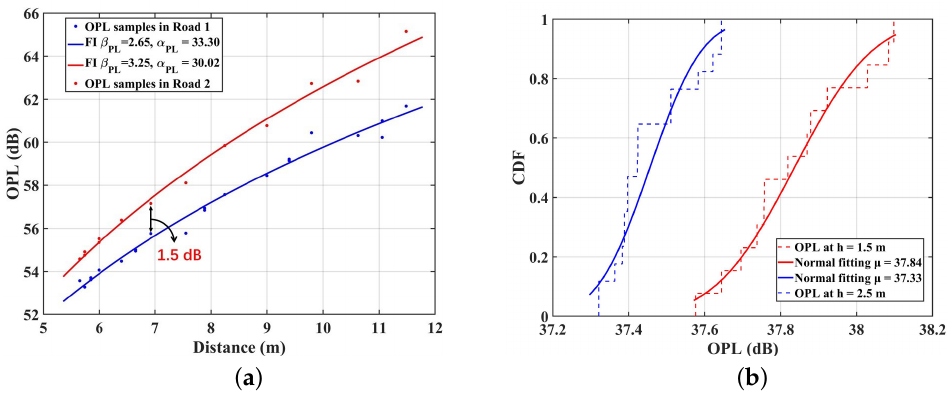
Figure 3. ( a ) The distance dependence of OPL under single TX case; ( b ) the CDF of OPL under the multiple TX case in Road